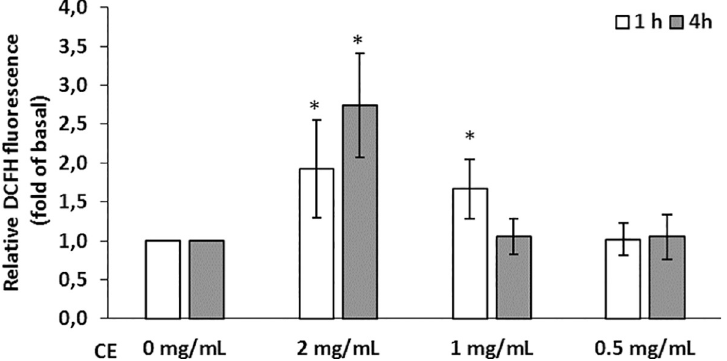
Fig 6. A . simplex crude extract leads to oxidative stress. Reactive oxygen species production, expressed as relative fluorescence, in Caco-2 cells after incubation for 1 and 4 hours with 2, 1 and 0.5mg/mL CE. The results are expressed as mean ± SD. The asterisks indicate significant differences between the control (0mg/mL) and 2mg/mL 1hour (P = 0.048, 95%CI = -1.8—-0.1) and 4 hours (P = 0.008, 95%CI = -2.9—-0.75), and 1mg/mL 1hour (P = 0.036, 95%CI =